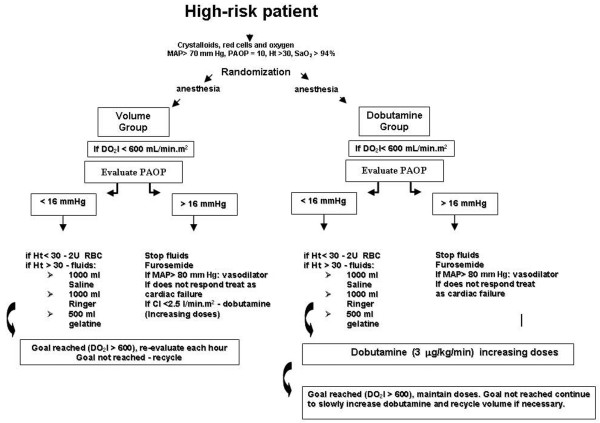
Treatment algorithm. MAP, mean arterial pressure; PAOP, pulmonary artery occlusion pressure; Ht, hematocrit; SaO2, arterial oxygen saturation; DO2I, oxygen delivery index; RBC, red blood cells; CI, cardiac index.